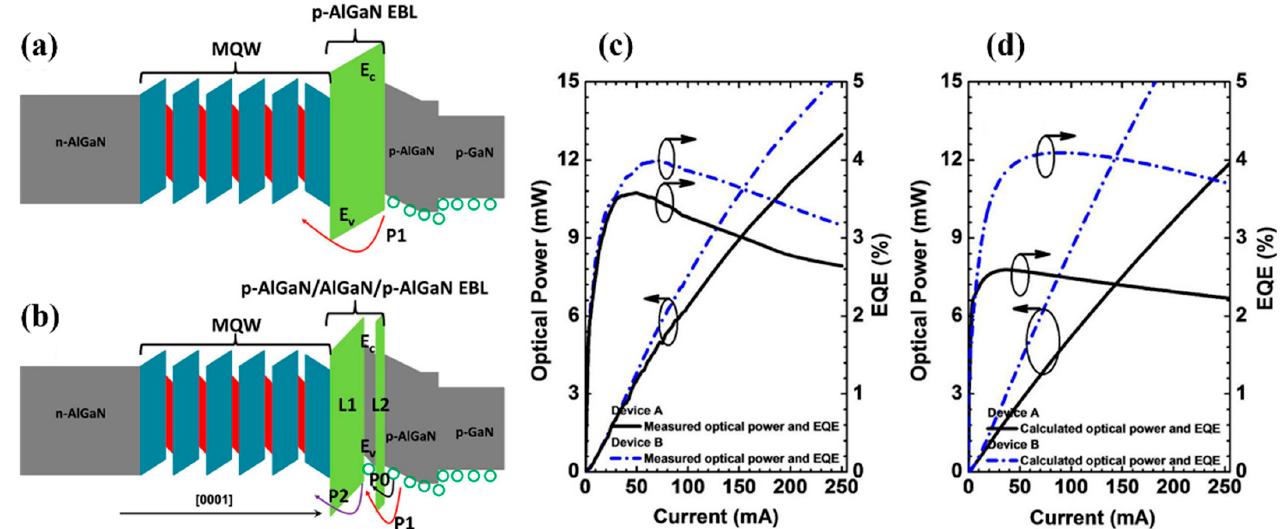
Figure 2. Schematic energy band diagrams for ( a ) DUV LEDs with the conventional p-AlGaN EBL and ( b ) DUV LEDs with the p-AlGaN/AlGaN/p-AlGaN EBL. ( c ) Experimentally tested and ( d ) numerically computed EQE and optical power at di ff erent injection current levels for devices A and B, respectively. Reproduced from Ref. [48] with permission from the American Chemical Society.